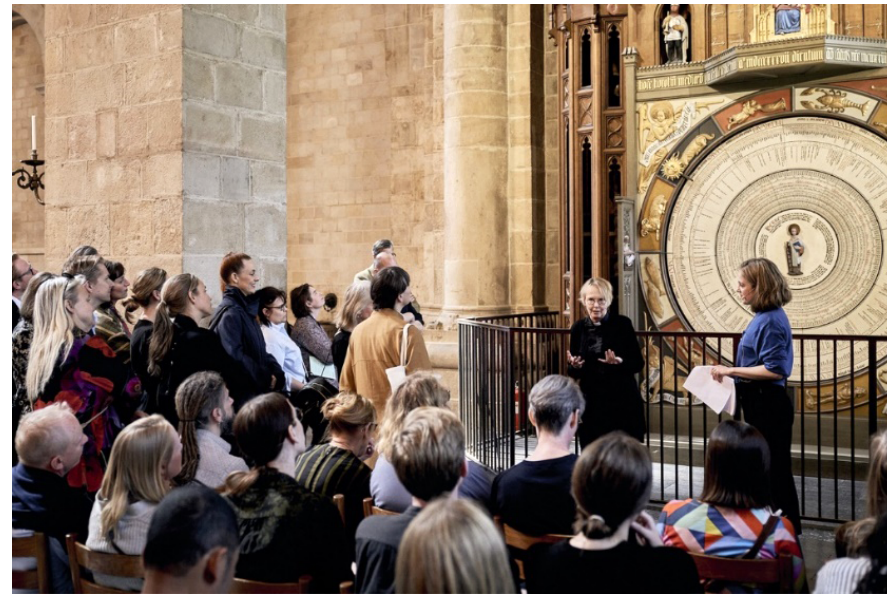
Figure 4. Time seminar in Lund Cathedral, 18 April 2018. Source: Peter